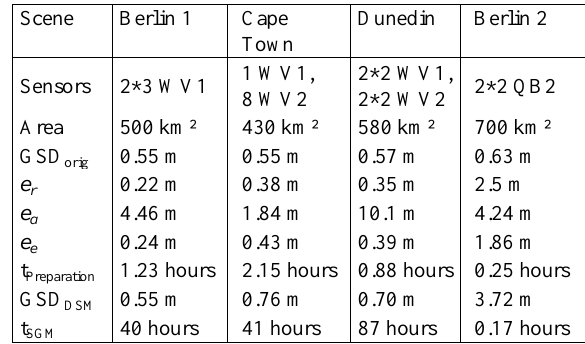
Table 2: Results of the tests. e r : The RMS of the spatial distances of corresponding lines of sight of independently selected homologous points (relative accuracy). e a : The RMS of the distances of the lines of sights from the GCP's absolute positions (absolute accuracy). e e : epipolarity error.